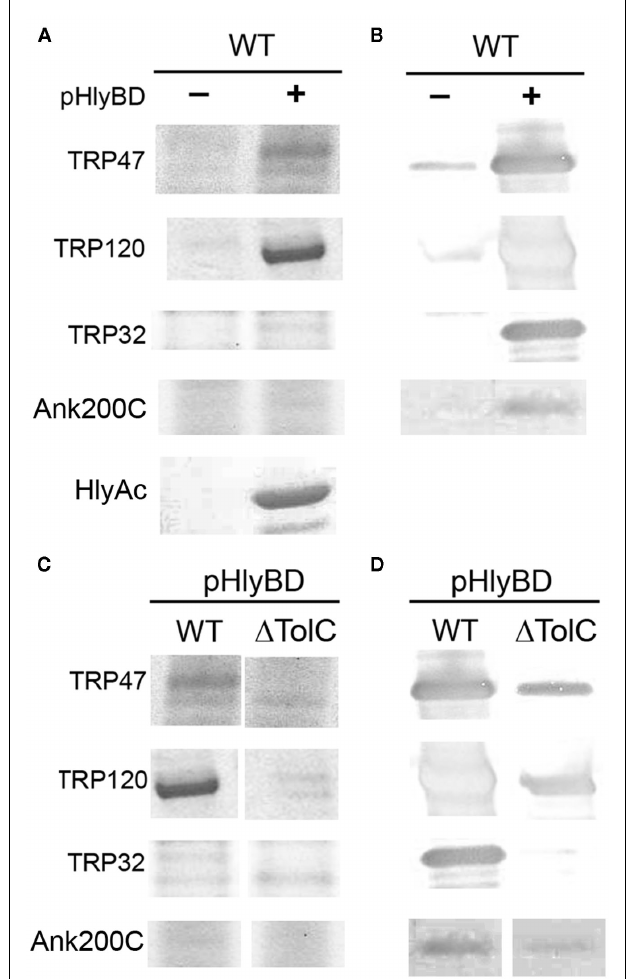
FIGURE 6 | Extracellular secretion of E. chaffeensis TRP47,TRP120, TRP32, andAnk200 from E. coli by HlyB and HlyD. (A,B) E. coli BW25113 cells transfected with pK184-HlyBD ( + ) and a plasmid encoding TRP47,TRP120,TRP32, Ank200-C (C-terminal 112 amino acids; C4), or HlyAc as indicated were grown in LB medium supplemented with 1.5mM IPTG to induce hlyBD coexpression. At OD 660 = 0.8, the production of theTRP47, TRP120,TRP32, Ank200, or HlyAc proteins was induced by the addition of arabinose to a final concentration of 10mM arabinose. Five hours after induction, protein in the culture supernatants wasTCA-precipitated and analyzed by SDS-PAGE with Coomassie staining [ (A) , top left panel] or immunoblotting usingTRP47,TRP120,TRP32, and Ank200 (C-terminal)-specific polyclonal antibodies [ (B) , top right panel]. E. coli BW25113 cells containing only a plasmid encodingTRP47,TRP120,TRP32, Ank200-C, or HlyAc protein but not containing pK184-HlyBD (indicated with − ) were cultured, and proteins expressed and purified as described above and analyzed by SDS-PAGE with Coomassie staining [ (A) , top left panel] or immunoblotting usingTRP47,TRP120,TRP32, and Ank200 (C-terminal)-specific polyclonal antibodies [ (B) , top right panel]. (C,D) E. coli BW25113 (WT) and CAG12184 ( Δ TolC) cells containing pK184-HlyBD ( + ) and a plasmid encodingTRP47,TRP120,TRP32, or Ank200-C as indicated were cultured and proteins expressed and purified as described above. Coomassie staining, [ (C) bottom left panel] or immunoblotting usingTRP47, TRP120,TRP32, and Ank200 (C-terminal)-specific polyclonal antibodies [ (D) , bottom right panel]. “ − ” indicates in the absence presence of pK184-HlyBD and “ + ” indicates in the presence of